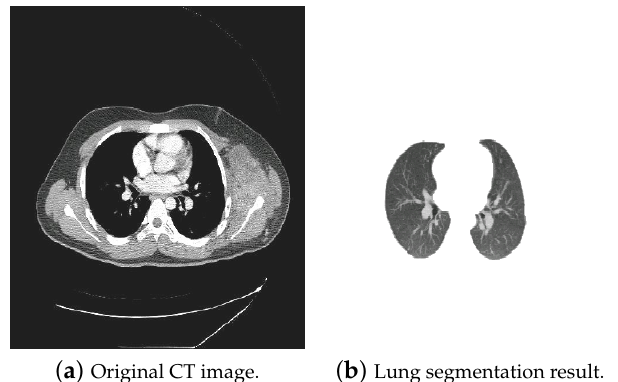
Figure 6. Lung segmentation